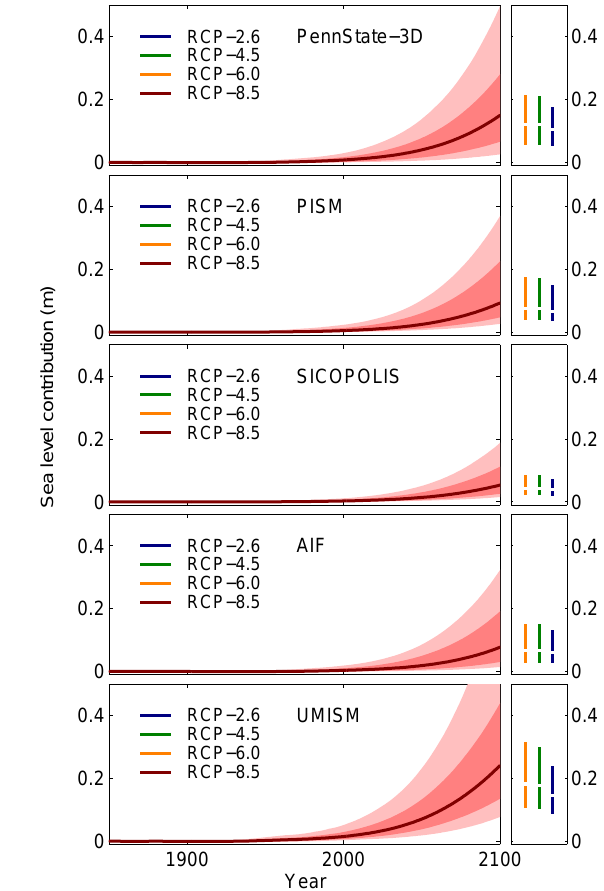
Figure 10. Uncertainty range of contributions to global sea level from basal-melt induced ice discharge from Antarctica for the dif- ferent ice-sheet models. Lines, shading and colour coding as in Fig. 8. Coloured bars at the right show the other scenarios’ 66% range intersected by the median.